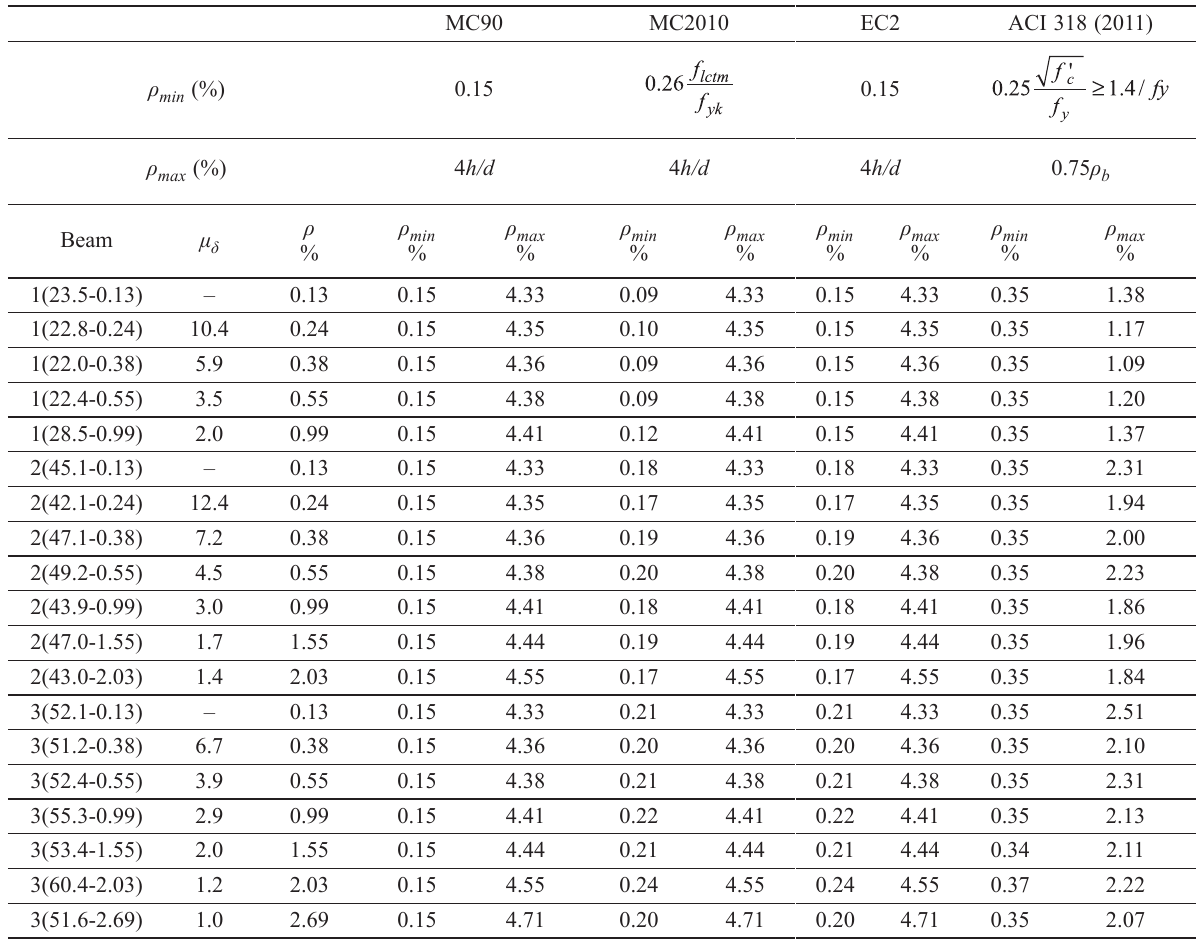
Table 7. Limits for the tensile reinforcement